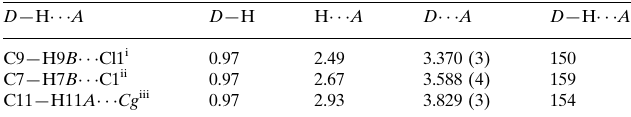
Hydrogen-bond geometry (A˚ , (cid:2)